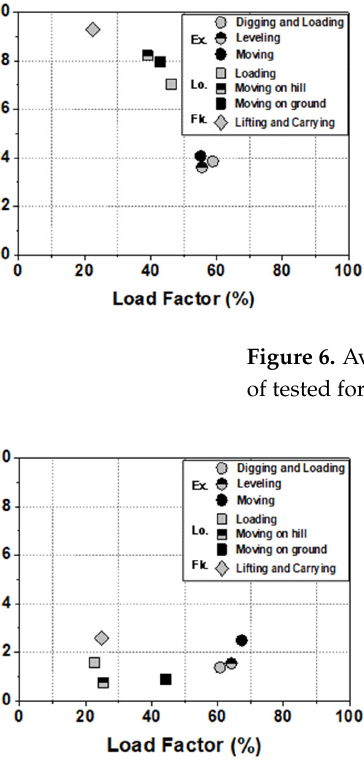
Figure 7. Average brake-specific emissions in according to load factor as real-world working modes of tested for K-tier4 construction machinery.